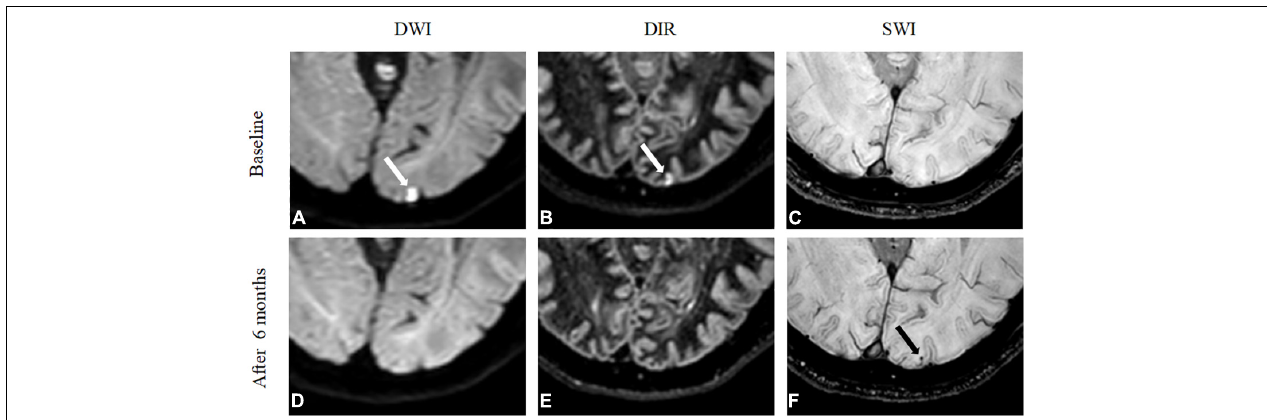
FIGURE 2 | De novo cerebral microbleeds matched with microinfarcts. A 71-year-old woman showed an embolic microinfarct that was detected in the left occipital lobe on DWI (A) and 3D-DIR (B) at baseline, but no abnormality was found on SWI (C) . After 6 months, DWI (D) and 3D-DIR (E) did not detect an abnormality. A de novo CMB was detected in the left occipital lobe by SWI (F) , and the lesion was in the same location as where the embolic infarction was detected on baseline MRI.